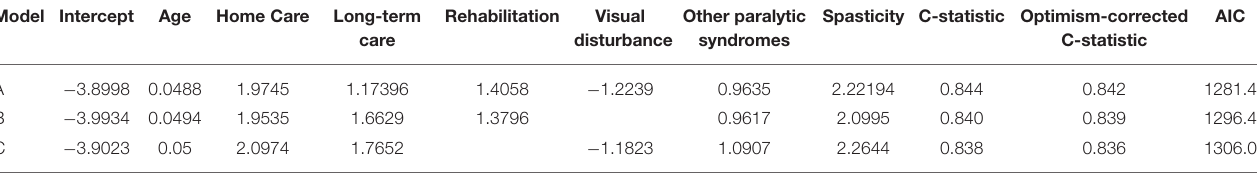
TABLE 3 | Logistic regression-based algorithm for severe disability (regression coefficients shown) *